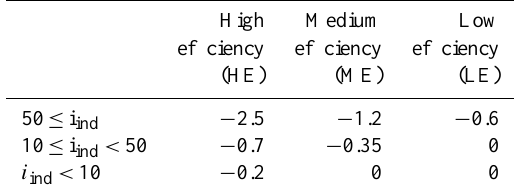
Table 6. Scenarios for irrigation efficiency change.